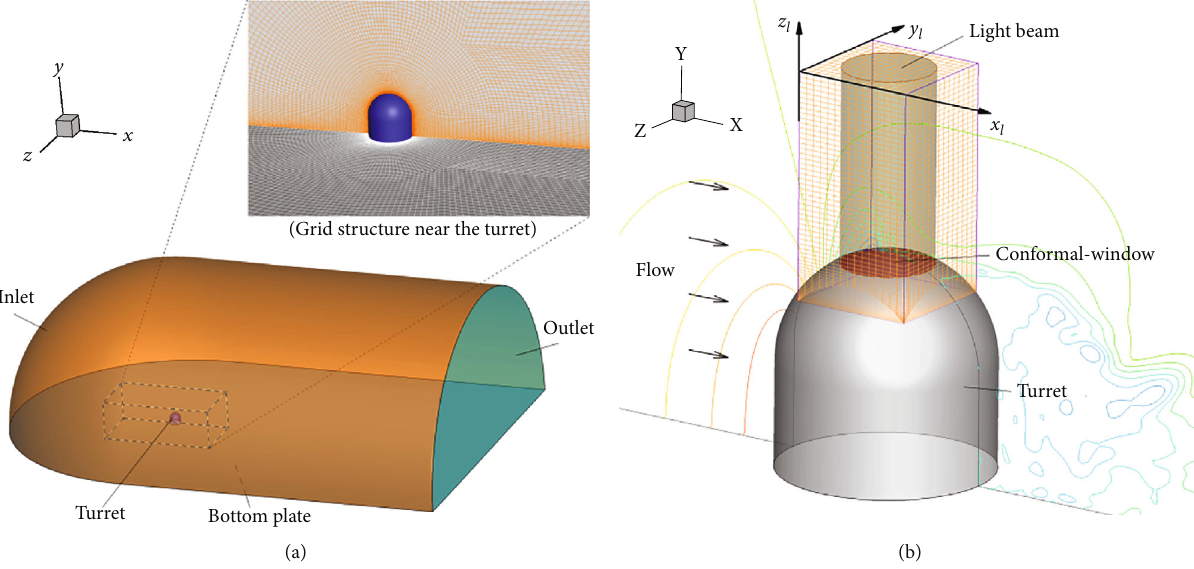
Figure 4: Computational domain and mesh for simulation: (a) fl uid and (b)